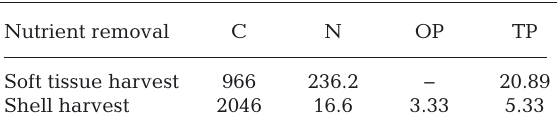
Table 10. Annual nutrient removals (in tonnes) from the Laizhou Bay ecosystem through the harvest of bay scallops in November. C: carbon; N: nitrogen; TP: total phosphorus; OP: organic phosphorus; (−) not